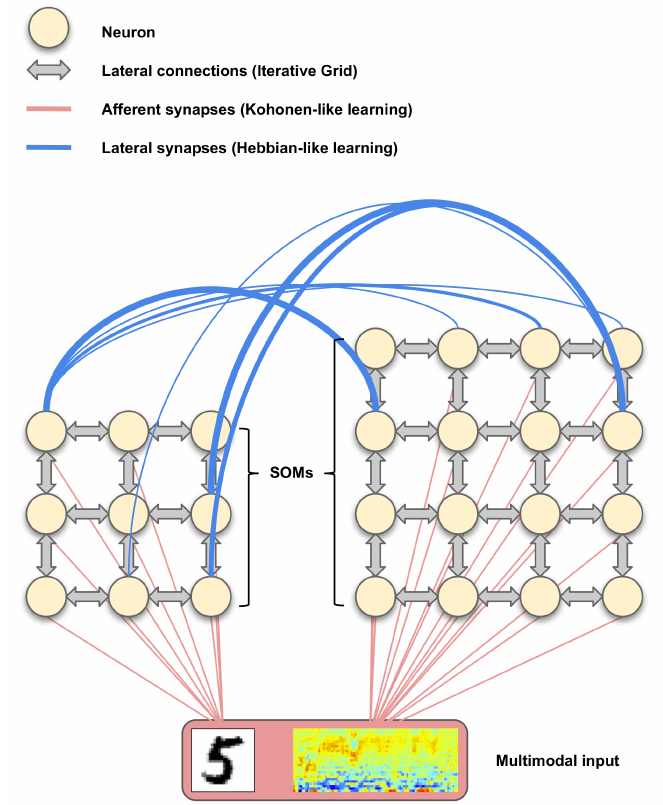
Figure 2. Schematic representation of the proposed Reentrent Self-Organizing Map (ReSOM) for multimodal association. For clarity, the lateral connections of only two neurons from each map are